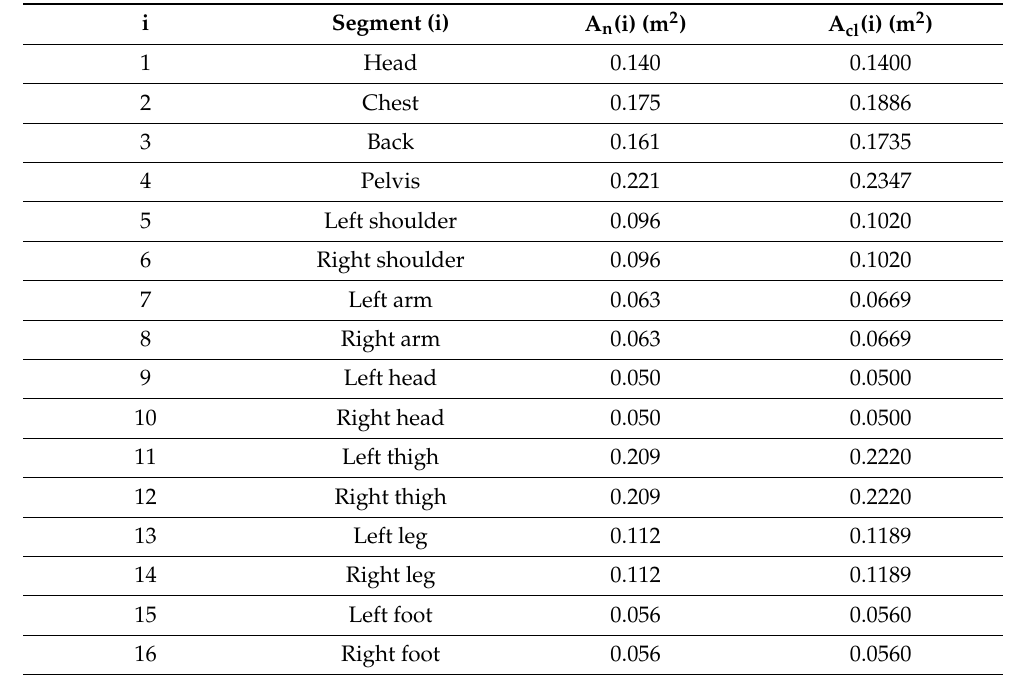
Figure 5. C(i,j) (Wh/°C) for central blood = 2.610. Table 3. An(i) and